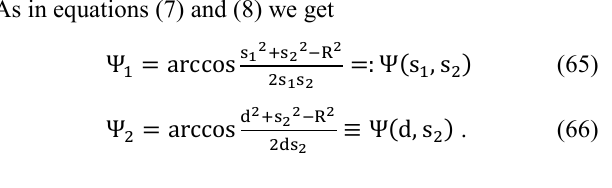
Figure 10: Polar coordinates ( ) for the projected inte- gration point . For constant , the angle varies between and